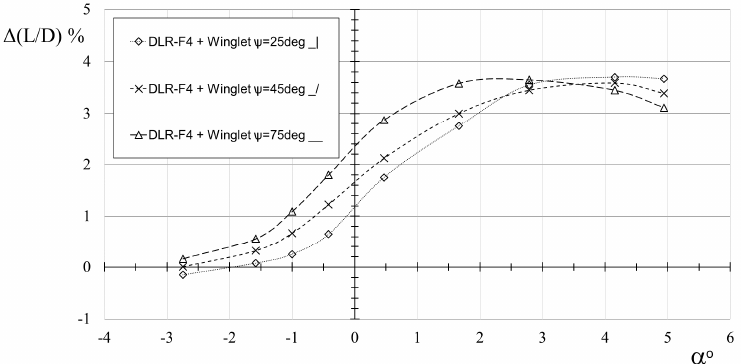
Figure 12. Dependence of overall improvement (%) in L / D ratio of DLR-F4 model on DLR-F4 geometric angle of attack due to the use of winglets of different cant angles. M = 0.75.